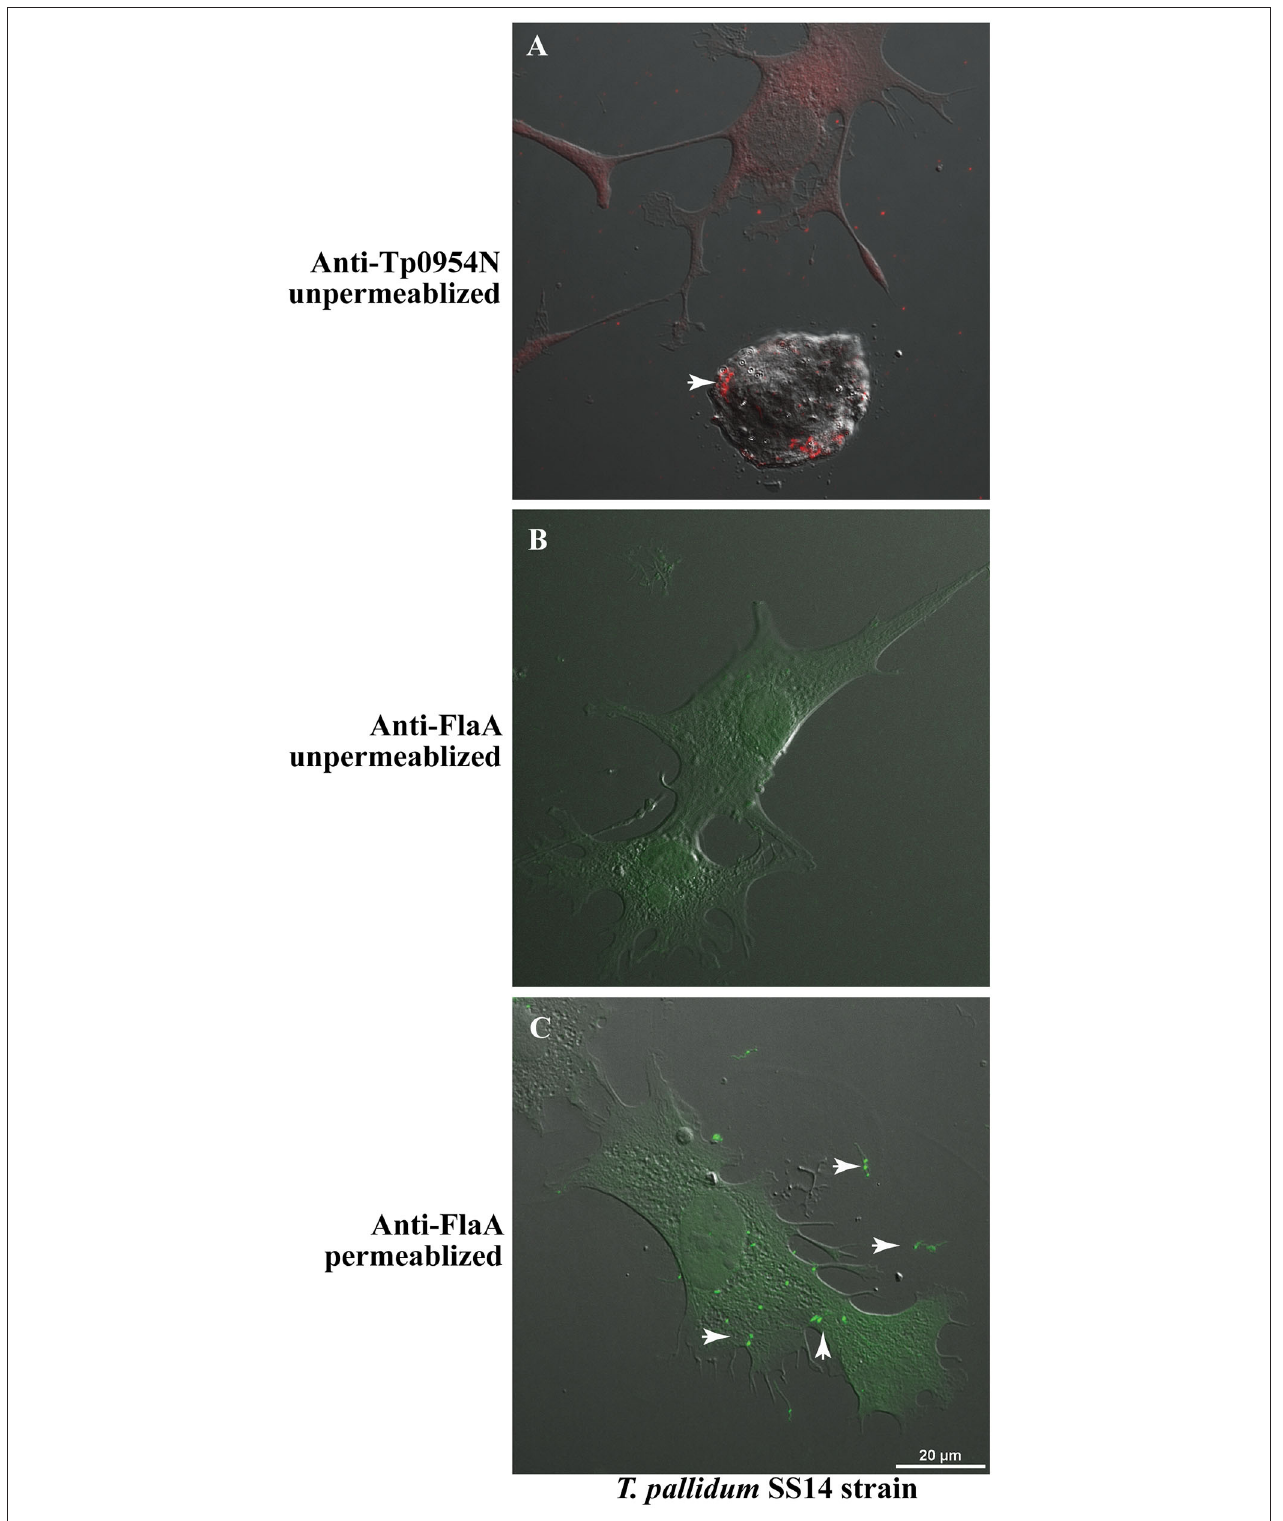
FIGURE 6 | IFA of T. pallidum co-cultured with low passage rabbit epithelial Sf1Ep cells. (A) IFA using primary polyclonal mouse anti-Tp0954N antibodies followed by TRITC-conjugated secondary antibodies using unpermeabilized T. pallidum SS14 strain co-cultured with Sf1Ep cells showed punctate staining confirming the surface localization of Tp0954. (B) The lack of staining of flagella by anti-FlaA in unpermeabilized T. pallidum indicate that integrity of outer membrane spirochetes was maintained during IFA procedure, and (C) staining of flagellar protein after permeabilization indicate antibodies reactivity and periplasmic location of flagella. Bar indicates 20 µ